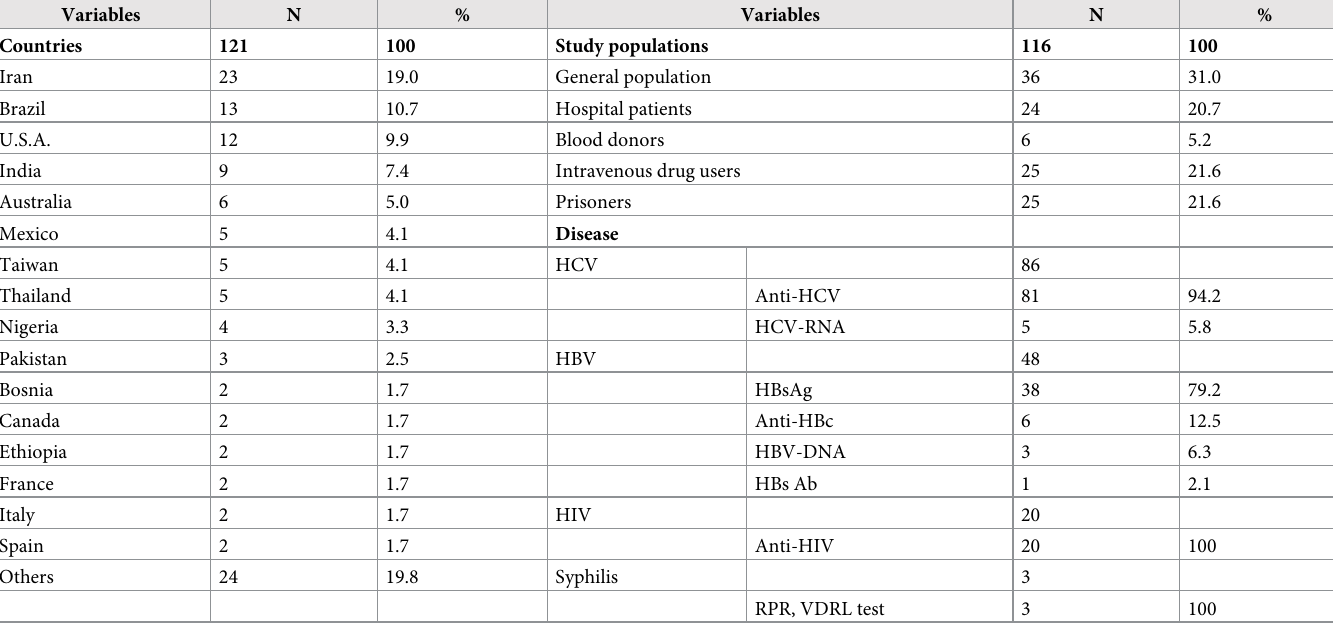
Table 1. Summary of the included